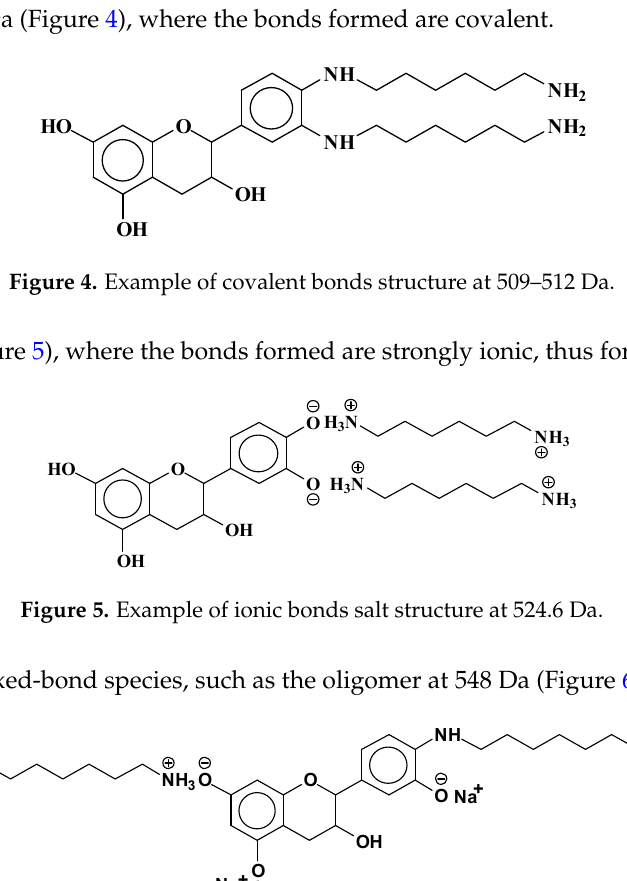
Figure 6. Example of mixed ionic and covalent bonds structure at 548 Da.